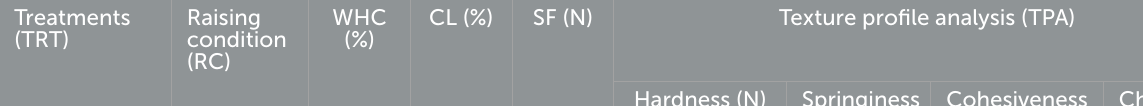
Texture profile analysis (TPA) Hardness (N) Springiness Cohesiveness Chewiness